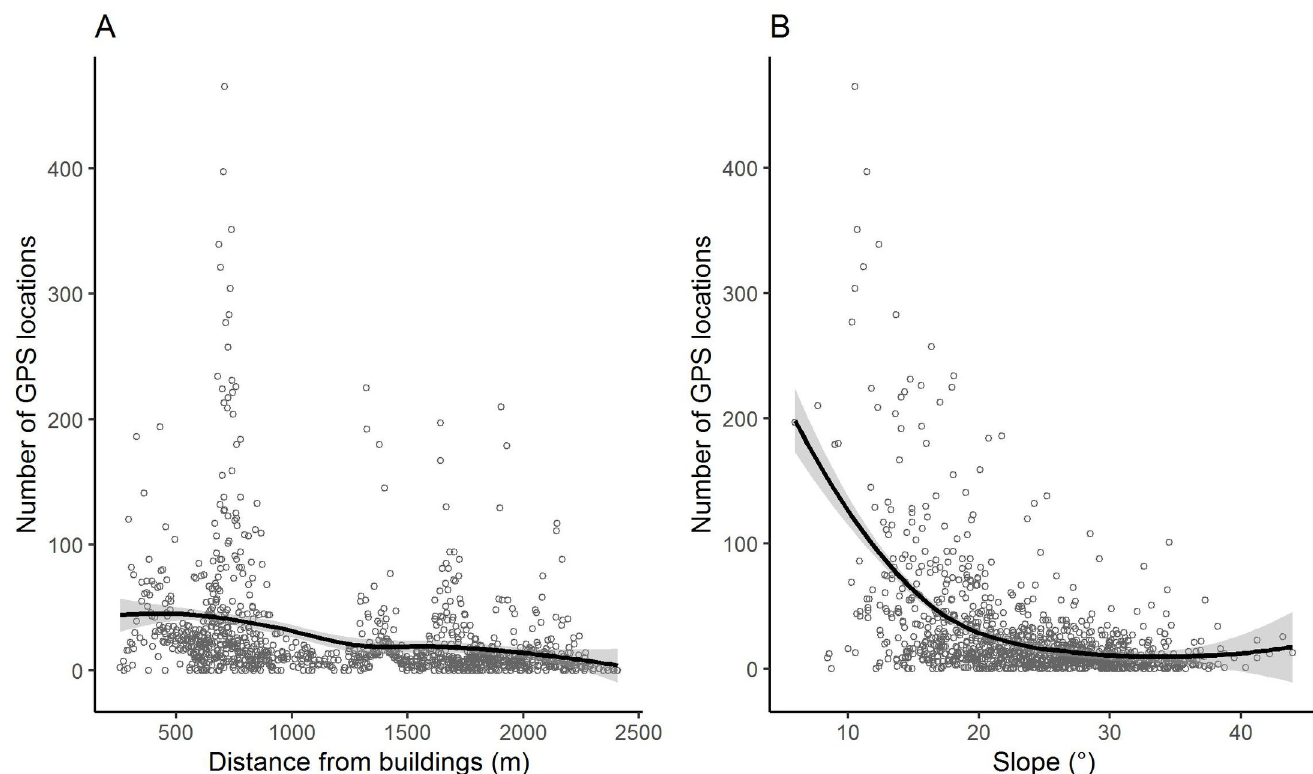
Fig 2. Scatterplots of the number of GPS locations versus the distance from buildings (A) and slope (B). A local weighted regression smoothing (LOESS) curve was added in each panel.